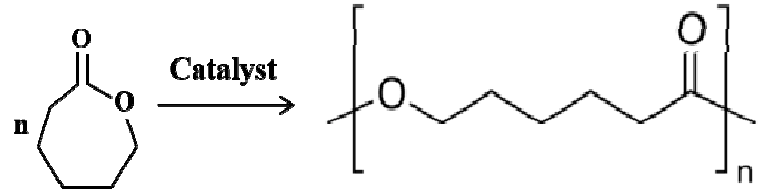
Figure 6. Synthesis of polycaprolactone (PCL): PCL is prepared by ring-opening polymerization of ε -caprolactone using a catalyst such as stannous octoate.